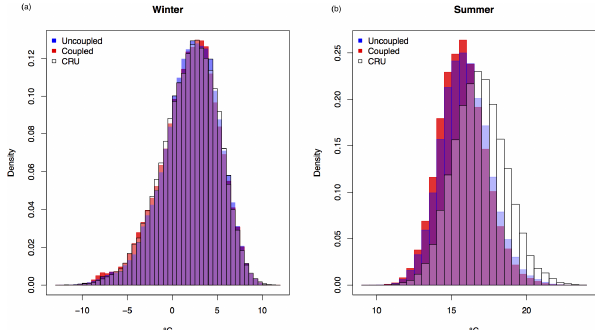
Figure 13. The 2m air temperature density histograms of the cou- pled and uncoupled systems compared to the CRU data over the PRUDENCE area mid-Europe during the 20th century in winter (a) and summer (b) . The coupled system is represented in red, the uncoupled in blue, CRU in white, and the data overlapping in pur-